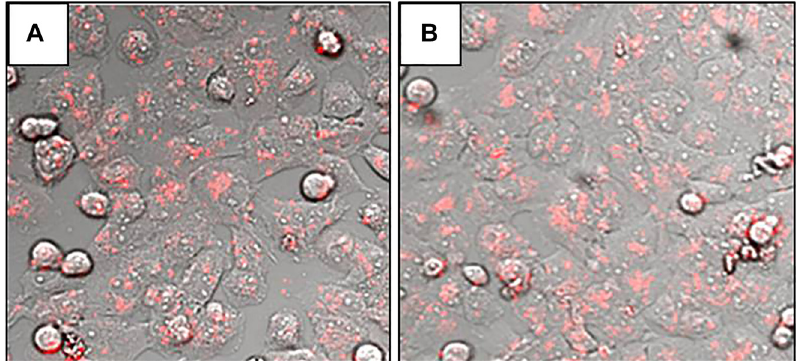
Figure 2: Observation of Cy3 labeled control siRNA within the cells under confocal microscope (Nikon, Japan, Cy3 was excited at 550 nm and emission was at 570